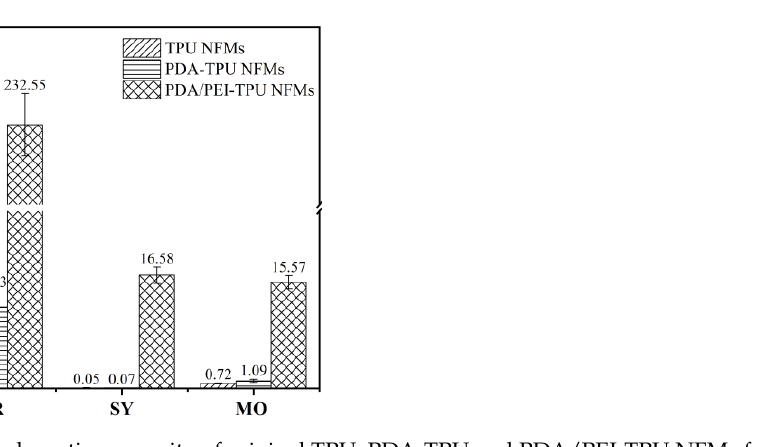
Figure 7. The adsorption capacity of original TPU, PDA-TPU and PDA/PEI-TPU NFMs for CR SY and MO dyes (dyes concentration: 100 mg/L, pH = 7).